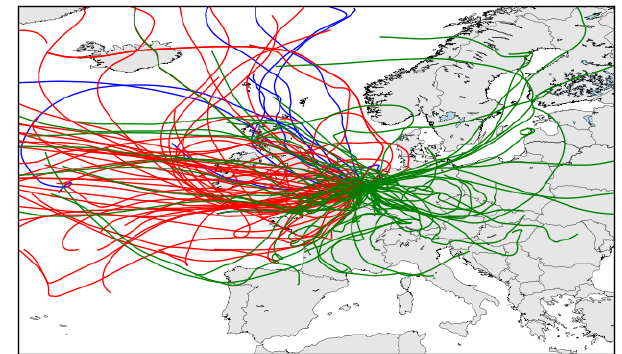
Figure 3. Ninety-six hour air mass back trajectories (NOAA HYS- PLIT) ending at a height of 50m for the filter samples classified as modified marine (red), marine (blue), and continental (green). For further analysis the blue trajectories were combined with the mod- ified marine trajectories (red) to represent aerosol samples, where the total carbon is dominated by regional emissions. Only samples for which air mass back trajectories were relatively stable over sev- eral days have been selected for